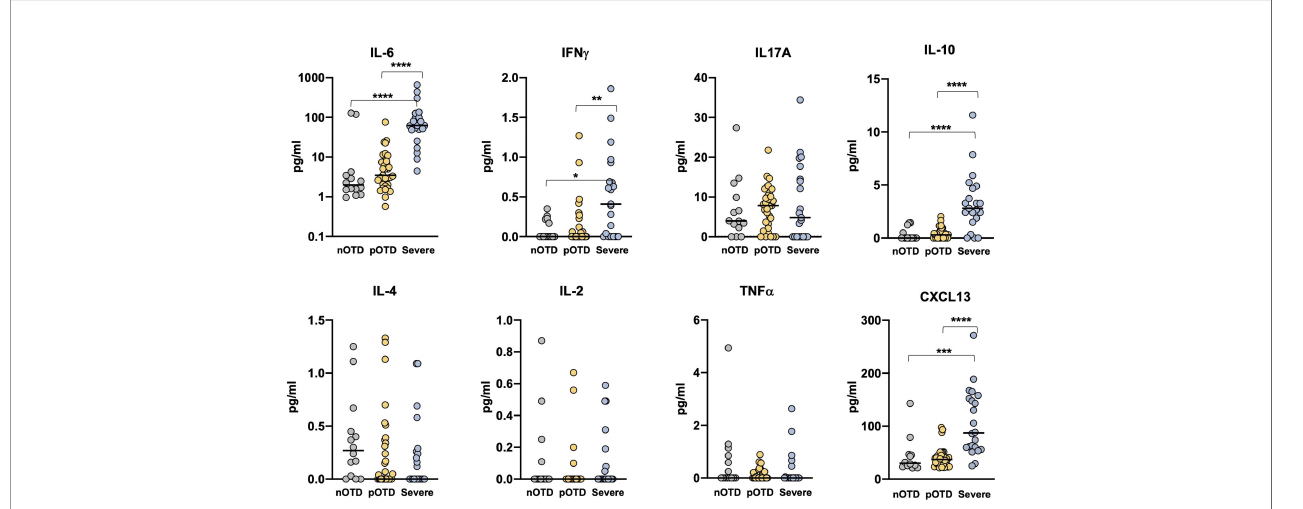
FIGURE 5 | Elevated serum in fl ammatory cytokines in severe COVID-19 patients. Serum levels of IL-6, IFN g , IL-17A, IL-10 (upper panels), IL-4, IL-2, TNF a and CXCL13 (lower panels) in OTD-CoV-2 neg subjects (nOTD), OTD-CoV-2 pos subjects (pOTD) and severe COVID-19 patients. Statistical comparisons between the three groups of subjects were assessed by the non-parametric Kruskal-Wallis test followed by Dunn ’ s multiple comparisons.**p < 0.01; ***p < 0.001; ****p <